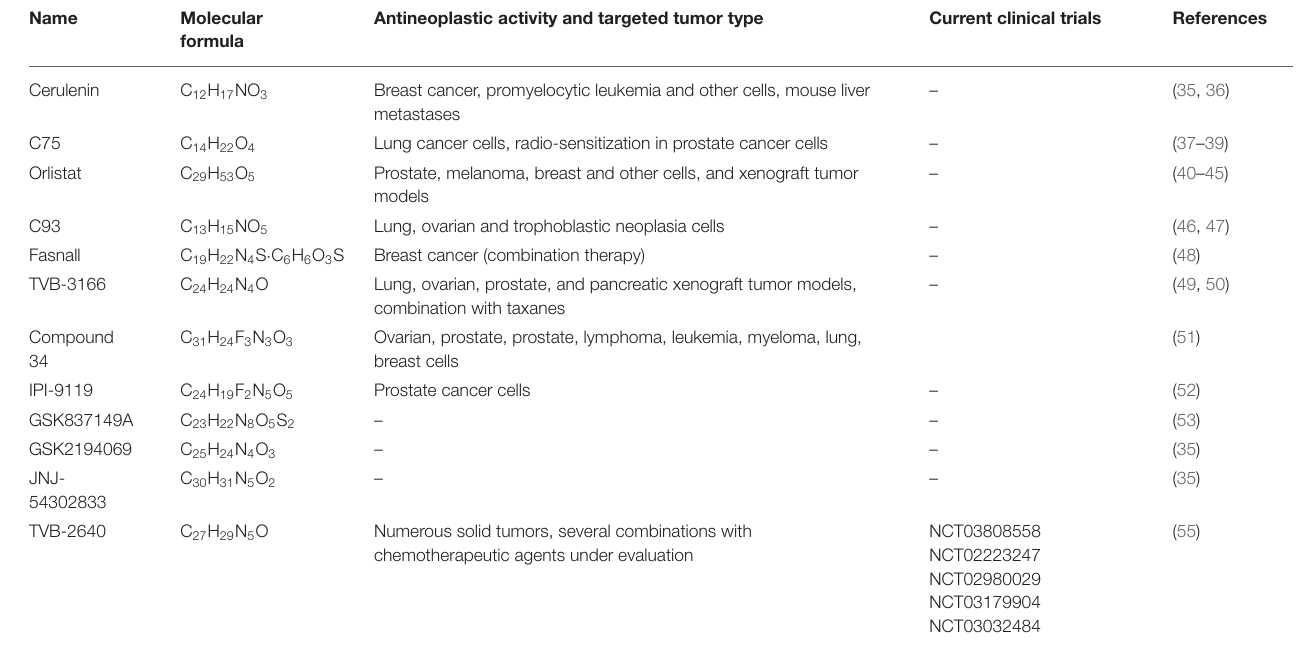
TABLE 1 | Current evidence on the antineoplastic properties of main FASN inhibitors in